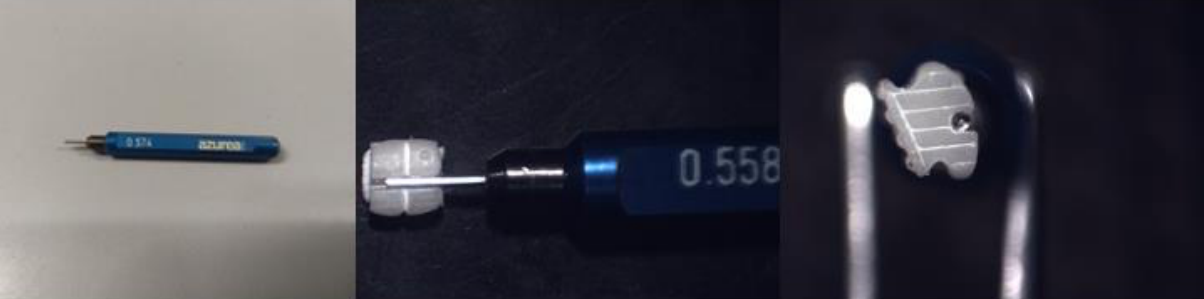
Figure 2. Azurea pin gauges (Azuréa Technologies S.A., Switzerland) and the microscopic image of the gauge inserted in the bottom of the slot.